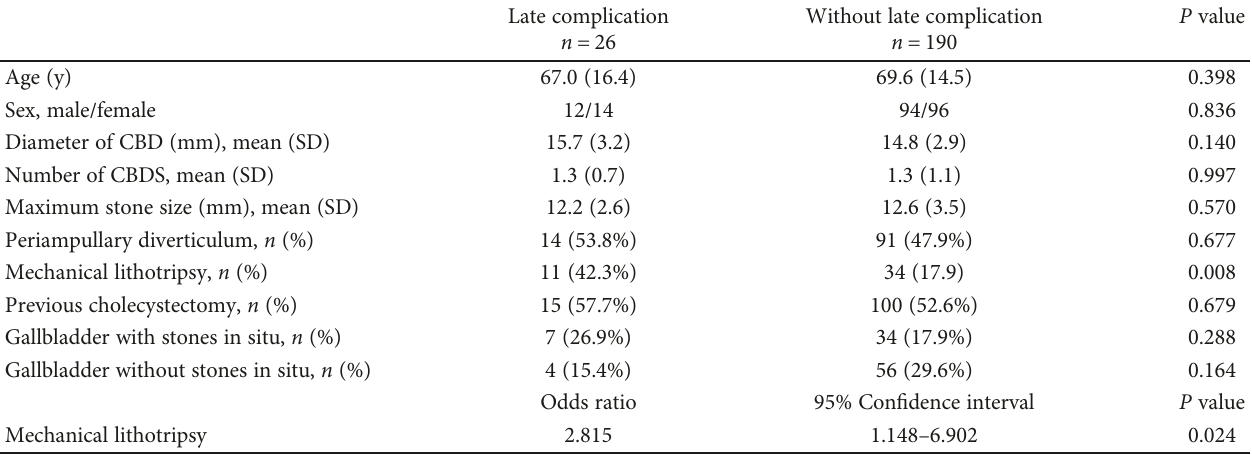
Table 5: Univariate and multivariate analyses for risk factors of the late biliary